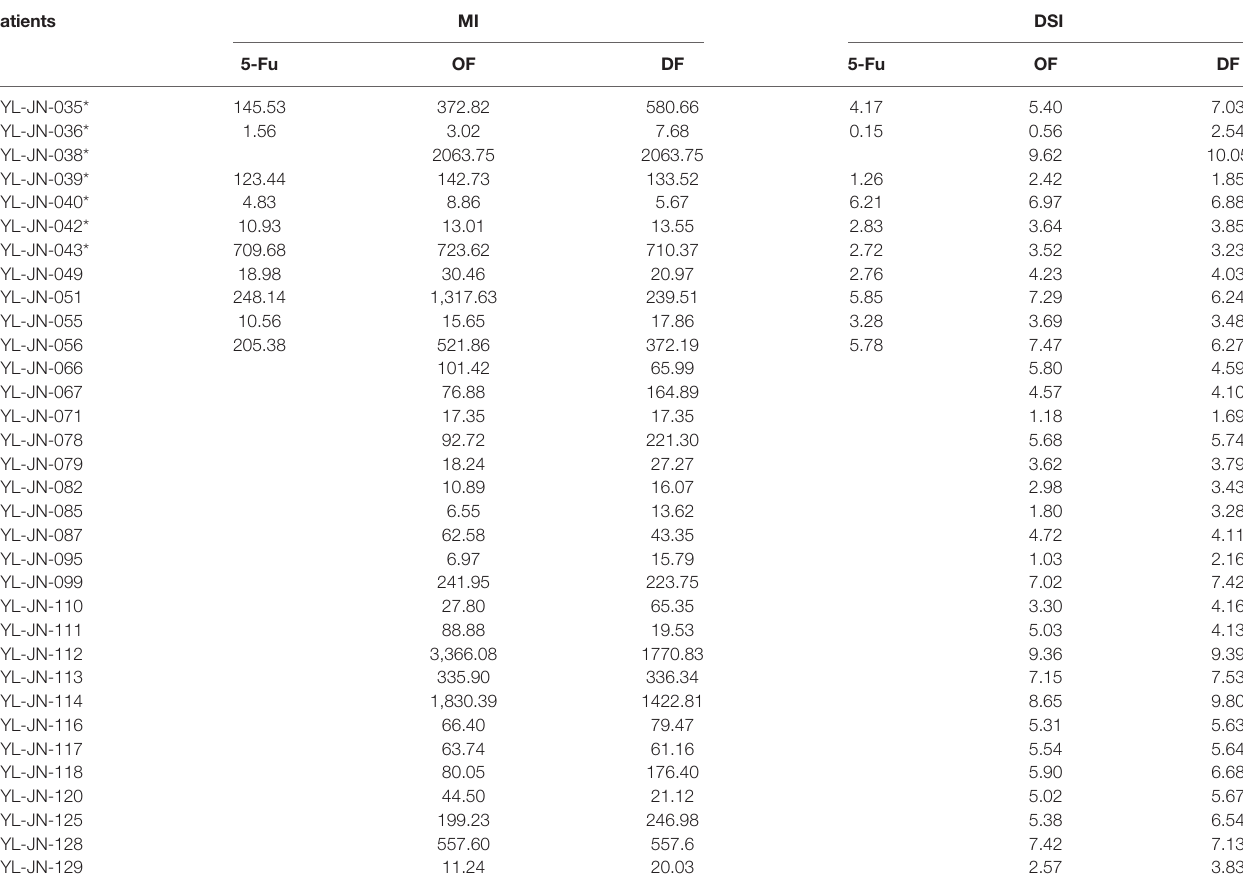
TABLE 2 | MI and DSI values of the therapeutic regimens for each patient.